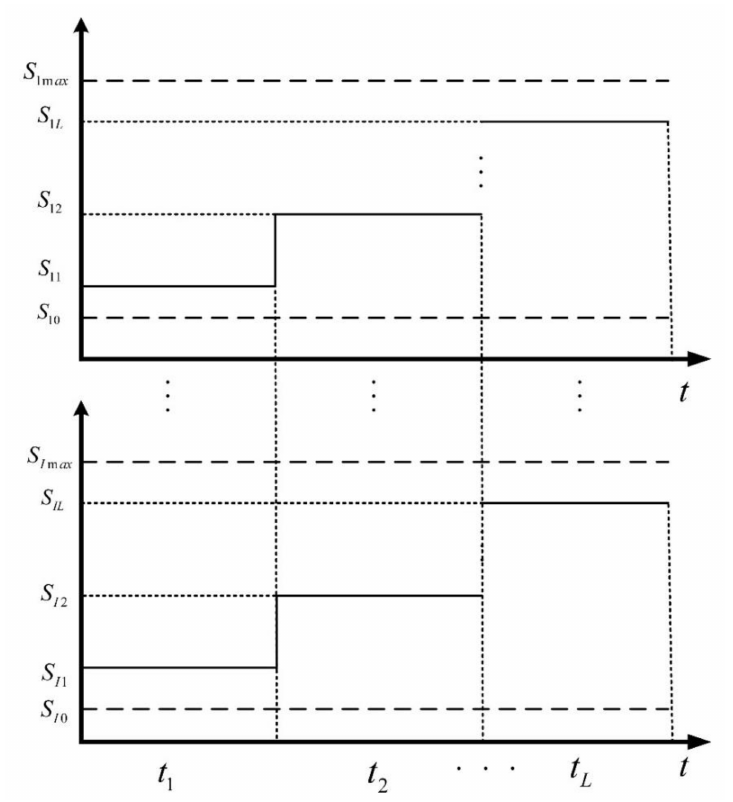
Figure 1. SSADT profile with multiple stresses.